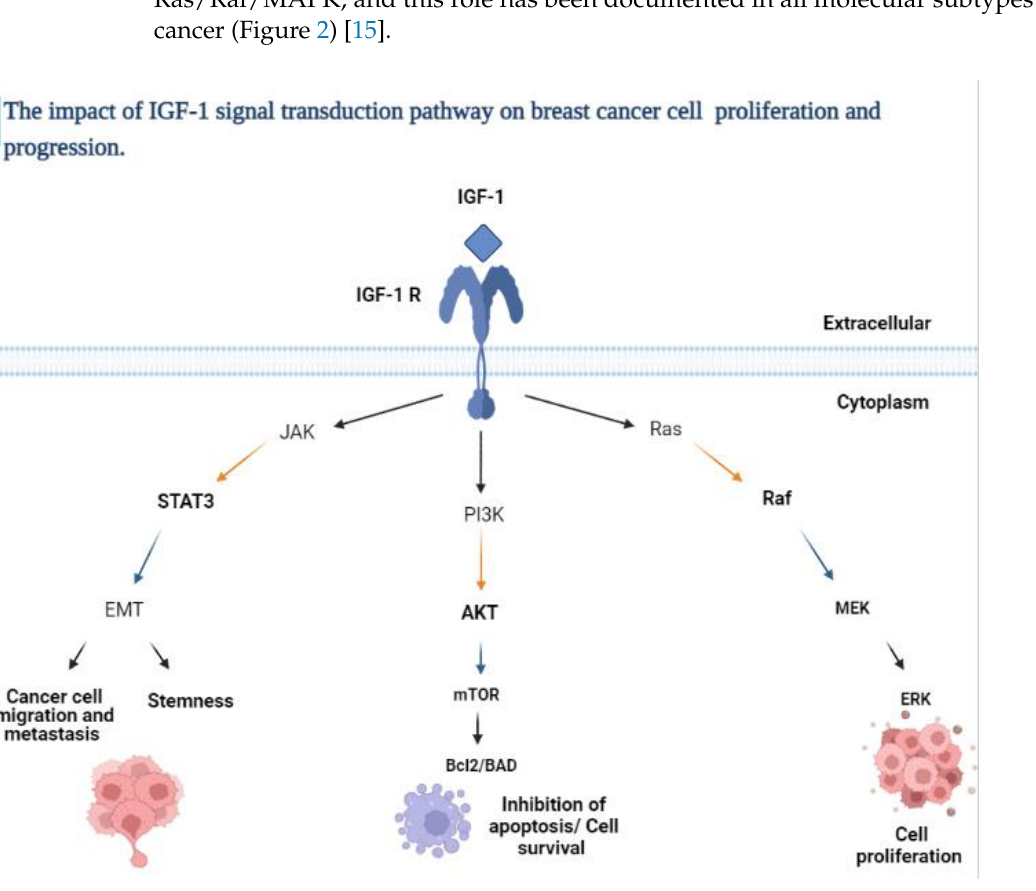
Figure 2. Schematic overview of the IGF-1 signaling pathway.